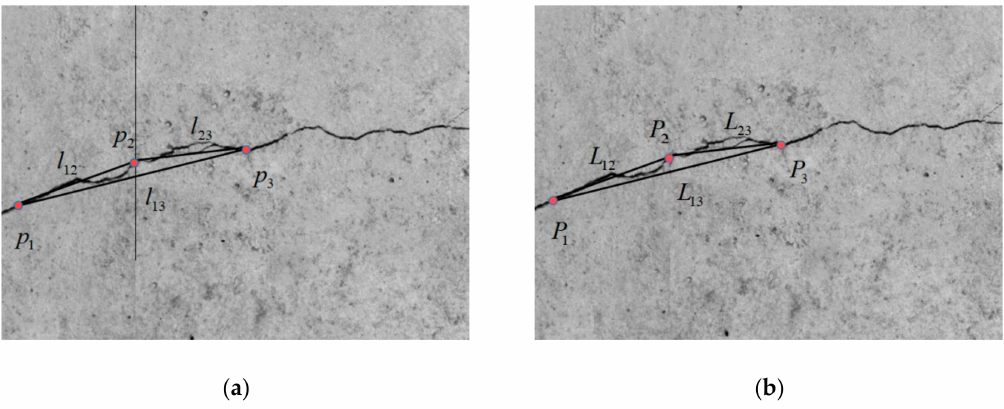
Figure 15. Comparison between two distances: ( a ) distance of the stitched image and ( b ) actual distance on the beam.